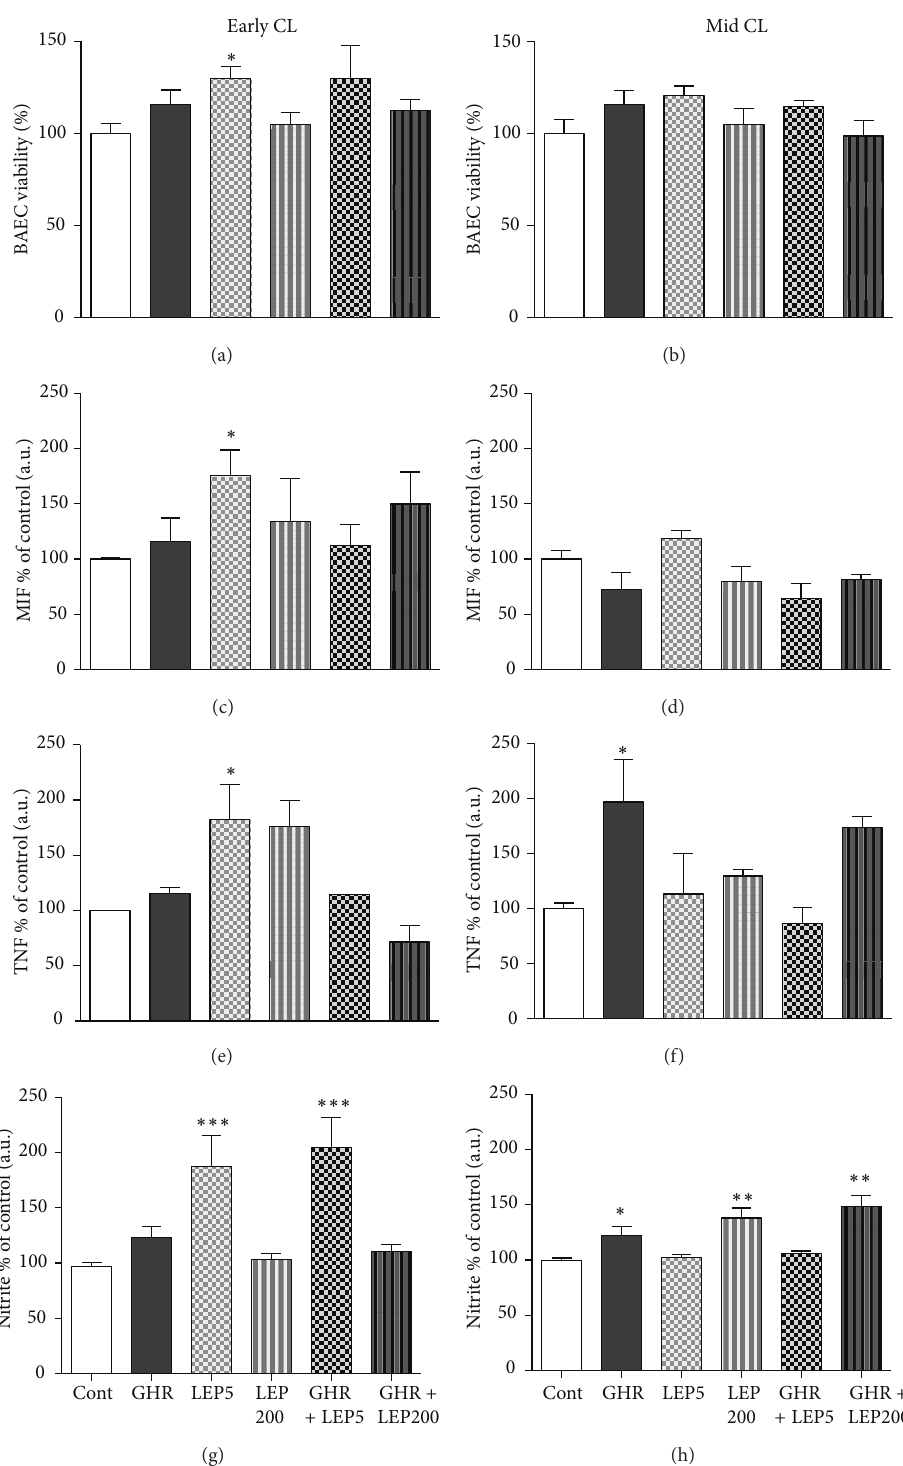
Figure 5: Early CL and mid-CL explants in vitro angiogenic activity, assessed after bovine aortic endothelial cell (BAEC) viability measurement ((a) and (b)) and secretion of migration inhibitory factor (MIF, (c) and (d)); tumor necrosis factor 𝛼 (TNF, (e) and (f)); and nitrite ((g) and (h)), after 24 h treatment with no exogenous factor = Control or with GHR (50 ng/mL), LEP (5ng/mL), LEP (200ng/mL), LEP (5ng/mL) + GHR (50ng/mL), or LEP (200 ng/mL) + GHR (50 ng/mL). Bars represent mean ± SEM. Different asterisks indicate significant differences ( ∗ 𝑃 < 0.05 ; ∗∗ 𝑃 < 0.01 ; ∗∗∗ 𝑃 < 0.001 ). Correspondent values of control for hormone production mean ± SEM: TNF ( 0.24 ± 0.009 ng/40 mg); MIF ( 27.47 ± 0.75 ng/mg); and nitrite ( 0.18 ± 0.037